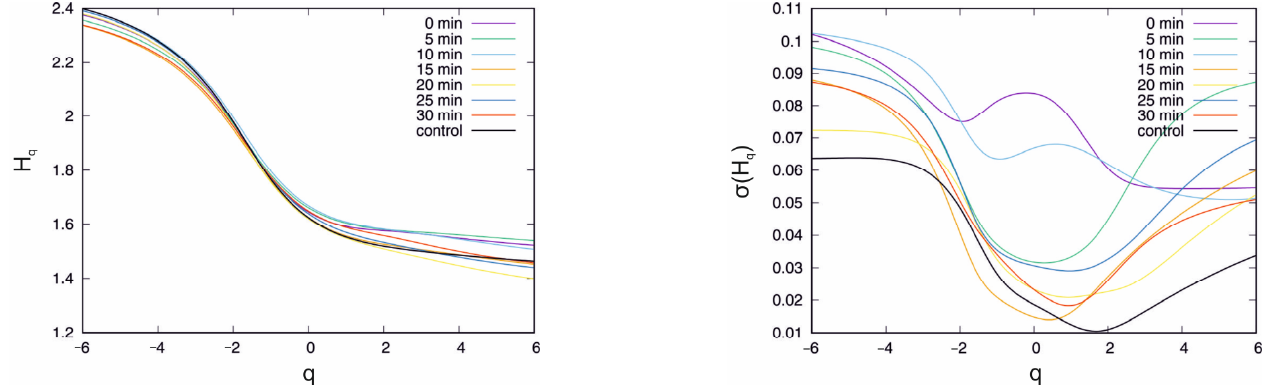
Figure 5. Mean value ( left ) and standard deviation ( right ) of the generalised Hurst exponent Hq in the presence of IAA at the chosen incubation times. U = −100 mV.